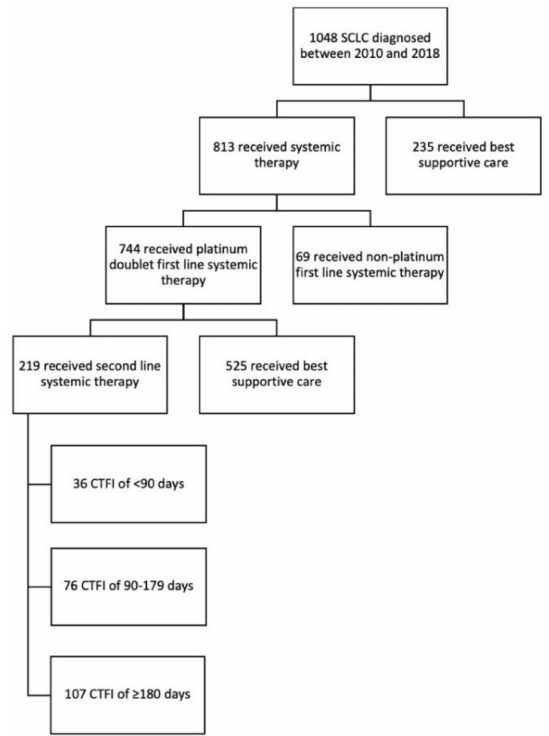
Figure 1. Consort diagram of small cell lung cancer